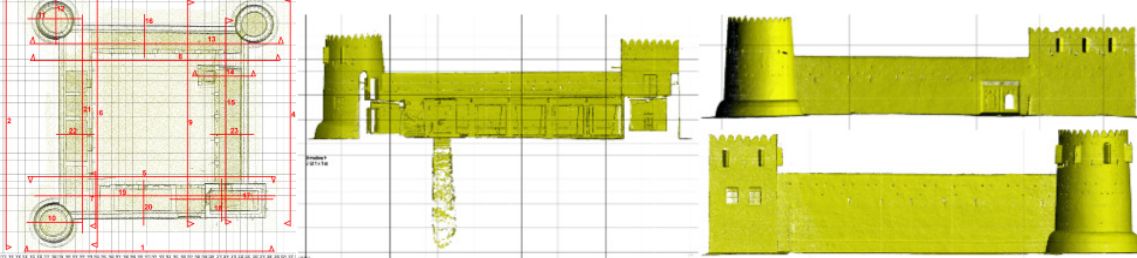
Figure 4: Overview sketch of the exported sections (left), three selected sections of Al Zubarah fortress – interior court yard with water well (centre) and two exterior walls